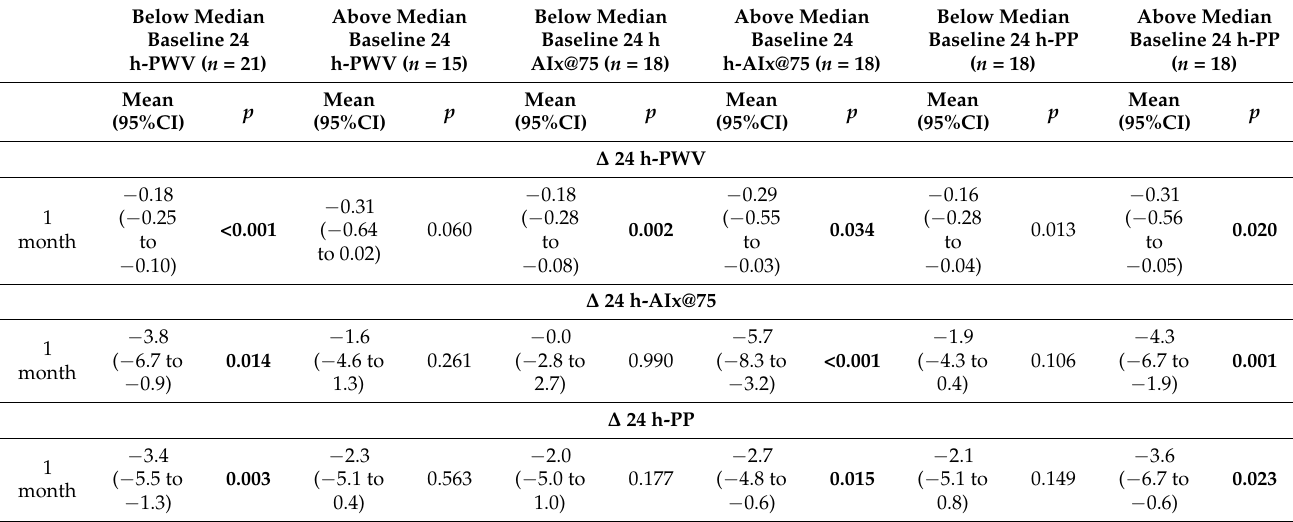
Table 4. Changes in AS markers according to the segmented population into two subsets above and below the median of baseline PWV, baseline AIx@75 and baseline 24 h PP,